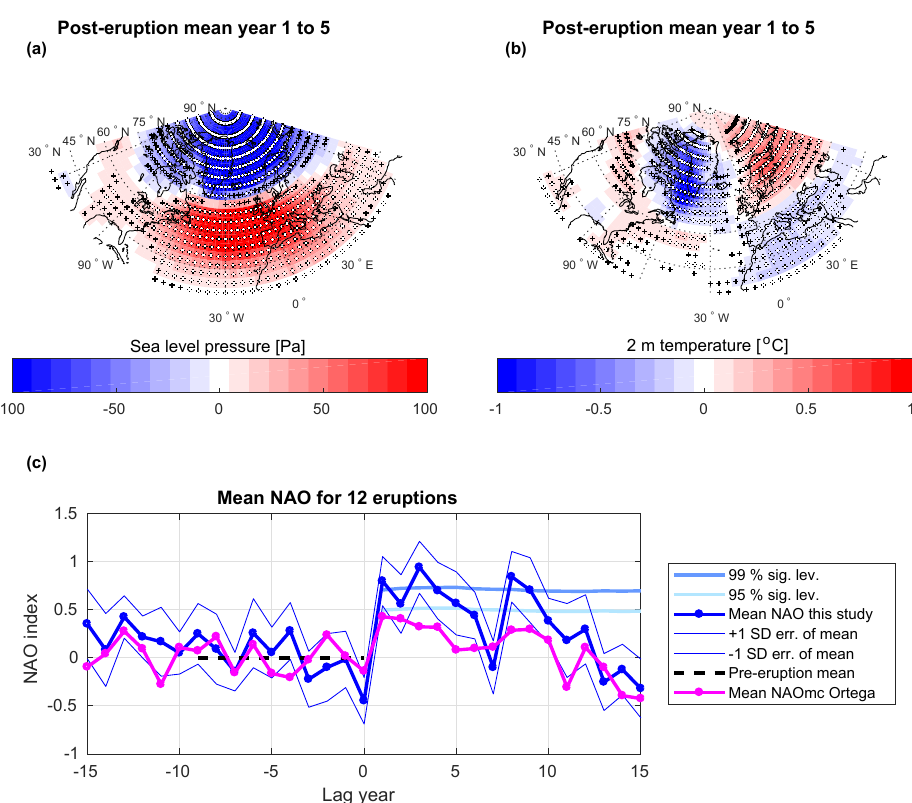
Figure 4. Superimposed epoch analysis of the mean response in atmospheric circulation to the 12 largest tropical volcanic eruptions (Sigl et al., 2015; Table S1). The response in SLP and T2m is normalized to the mean fields of the 10 years preceding the eruption. (a) Mean DJF SLP anomalies (Pa) for the first five post-eruption years. (b) Mean DJF T2m anomalies ( ◦ C) for the first five post-eruption years. The white stippling indicates significant anomalies p < 0 . 01, and black stippling indicates significant anomalies p < 0 . 05 (two-tailed Student’s t test). (c) Mean response in reconstructed NAO (blue) with the time series normalized to the mean NAO of the 10 years preceding the eruption. For comparison the same analysis is carried out for the NAOmc reconstruction (magenta) by Ortega et al. (2015). The significance levels in (c) are estimated from 100000 random samples of 12 years drawn from the reconstructed NAO. See Fig. S6 for significance levels for